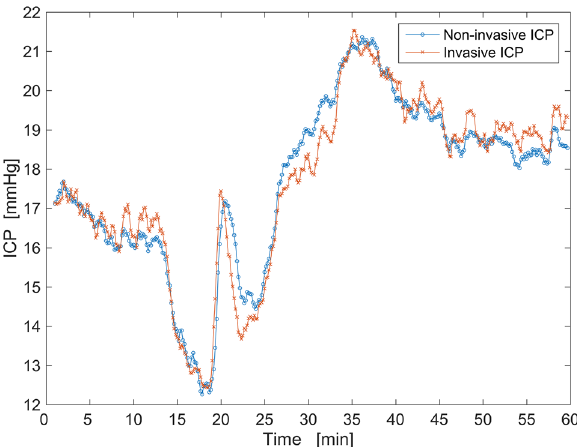
Figure 4. An example of paired invasive and non-invasive ICP data points of the first patient after filtering (60-s moving average filter).